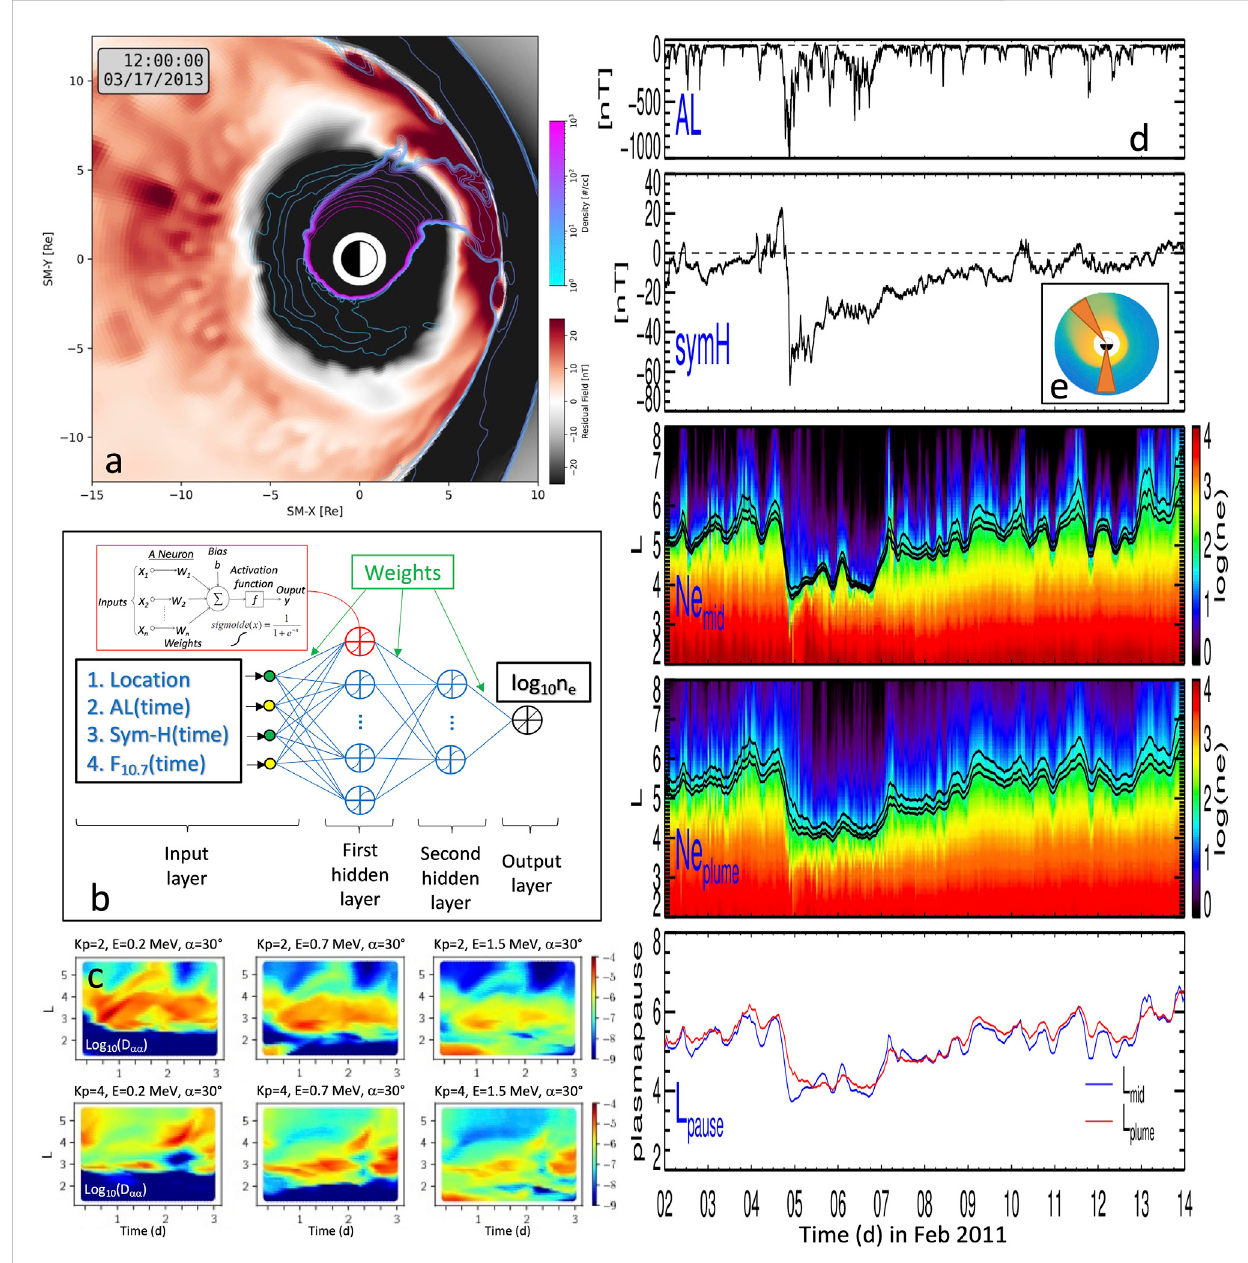
FIGURE 2 (A) Coupled GAMERA global geospace model and RCM simulation depicting localized nightside dipolarizations and dayside plasmaspheric plume. Shown is the non-dipolar component of the northward magnetic fi eld (left color bar) and contours of constant density (right color bar) in the equatorial plane(Sorathiaetal.,2018). (B) TheneuralnetworkarchitectureofDEN2DinChuetal.(2017a). (C) Predictionsofdiffusioncoef fi cientsforvariabledensity and wave properties from the neural network model of Ripoll et al. (2022b) during (top) quiet (Kp = 2) and (bottom) moderate (Kp = 4) activity. A Kp- based model of plasma density and wave properties would fi nd constant values in time. (D) Density and plasmapause location predicted by the DEN2D neural network at midnight (noted mid) and in the plume (noted plume) based on the AL and Sym-H indices in February 2011 during a re fi lling event showing dynamic rates of re fi lling (Chu et al., 2017b). (E) Equatorial density predicted by DEN2D and MLT sectors shown in (D)